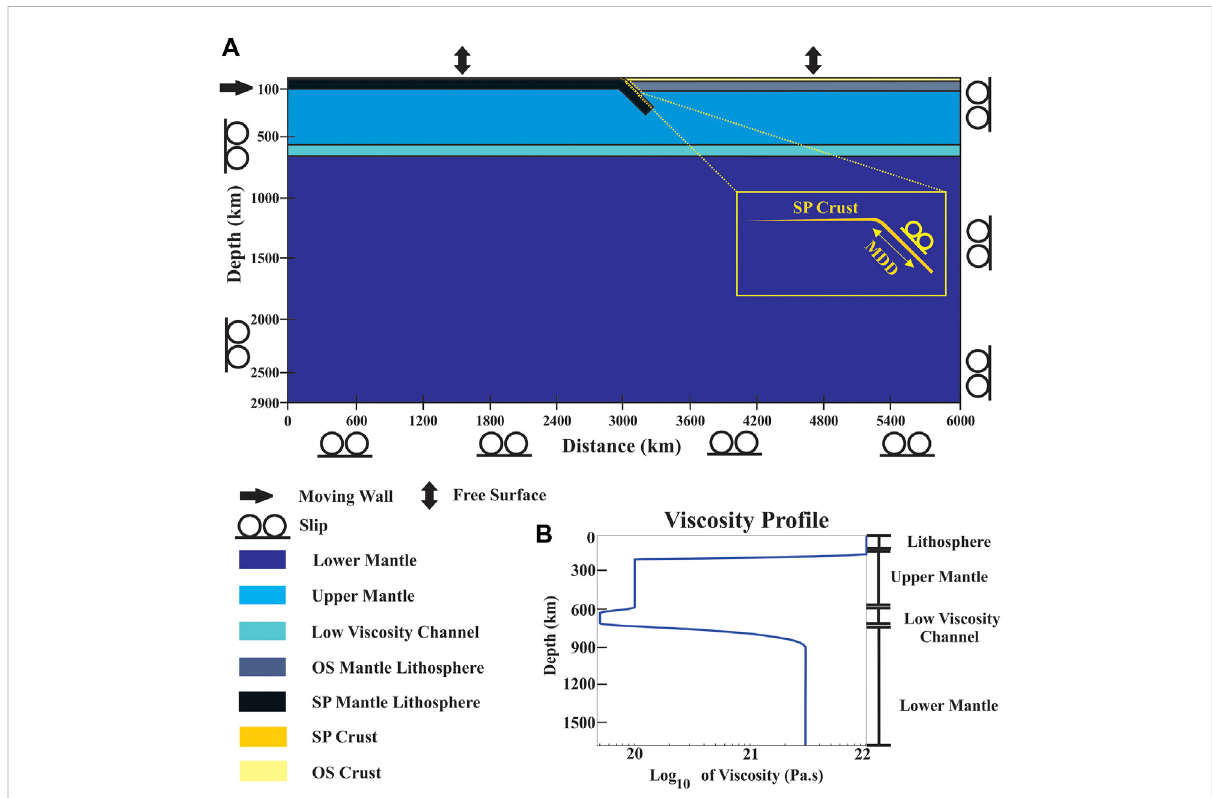
FIGURE 2 (A) Computational fl uid dynamic (CFD) model setup used for trench simulations in subduction zones. An oceanic lithosphere (left) subducts beneath a continental overriding plate (right side). A proto subduction is introduced in the initial model setup to initiate the subduction process. The model dimensions, domains, and boundary conditions are explained in the lower panel. (B) Consideration of the initial viscosity – depth pro fi le in the model domain. The domain divisions: upper and lower mantles with an intervening low-viscosity channel are shown in the pro fi